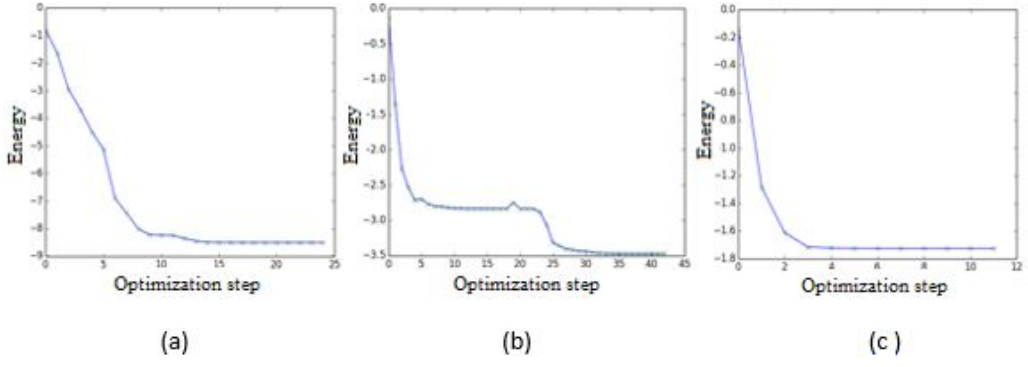
Figure 1: The different steps are utilized to treat and select a best geometry optimization of structures: (a) dopamine, (b) L-DOPA, (c)